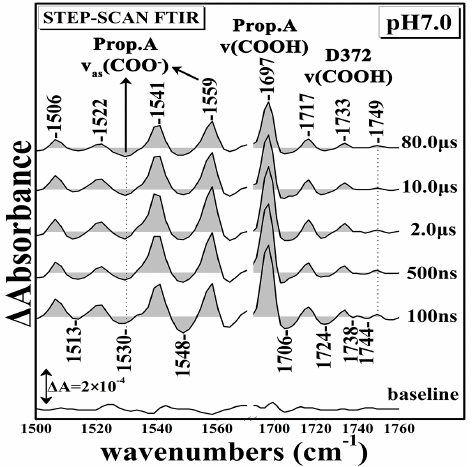
Figure 1. Time Resolved Step-Scan Fourier Transform Infrared (TRS 2 -FTIR) difference spectra of 1500–1760 cm − 1 region ( t d = 100–80,000 ns, 4 cm − 1 spectral resolution) of fully-reduced ba 3 -CO subsequent to CO photolysis by a 7 ns 532 nm laser pulse at pH 7.0.